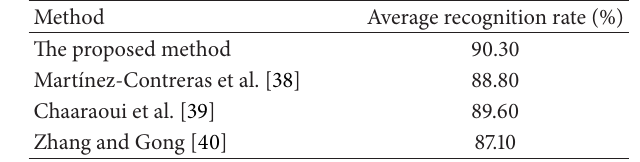
Table 5: Comparisonwith other approaches on KTH action dataset.